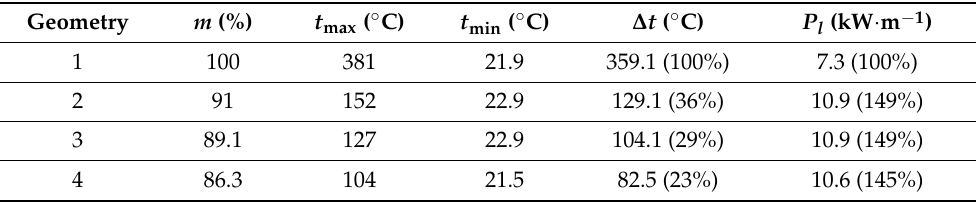
Table 1. A comparison of the metal hydride mass, temperatures, and linear heat fluxes.